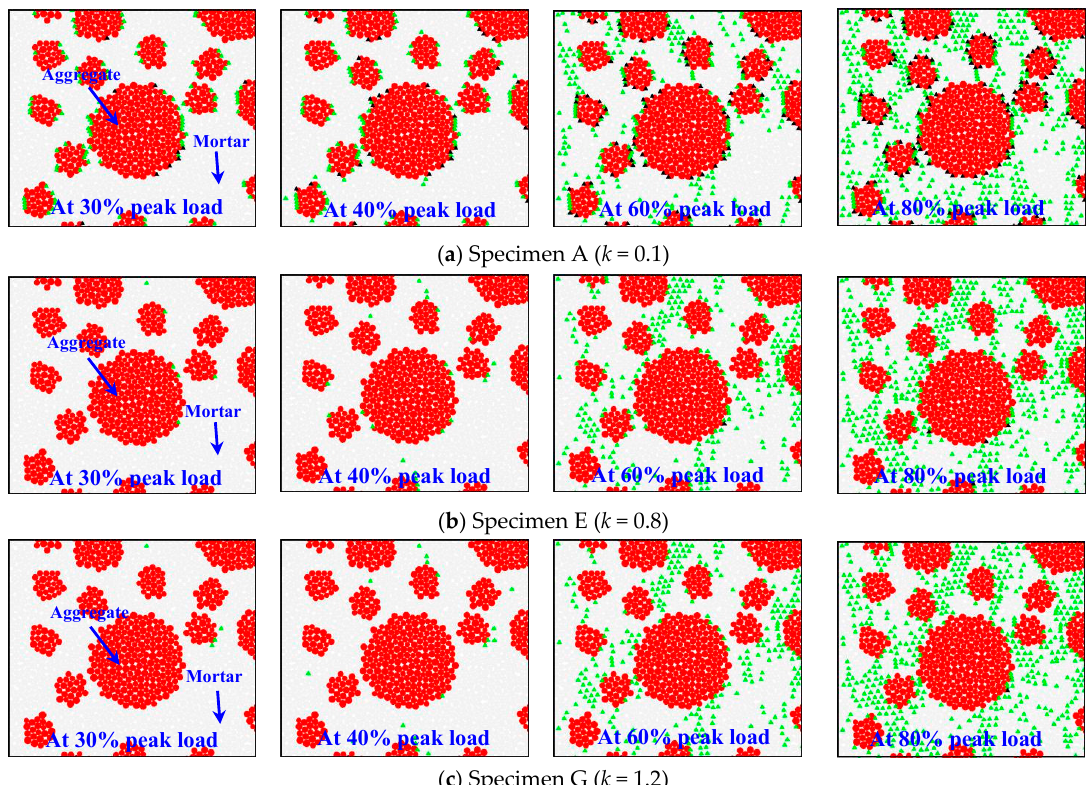
Figure 8. Microscale cracking in ordinary concrete at stress levels of 30% to 80% of the ultimate load by discrete element method (DEM).